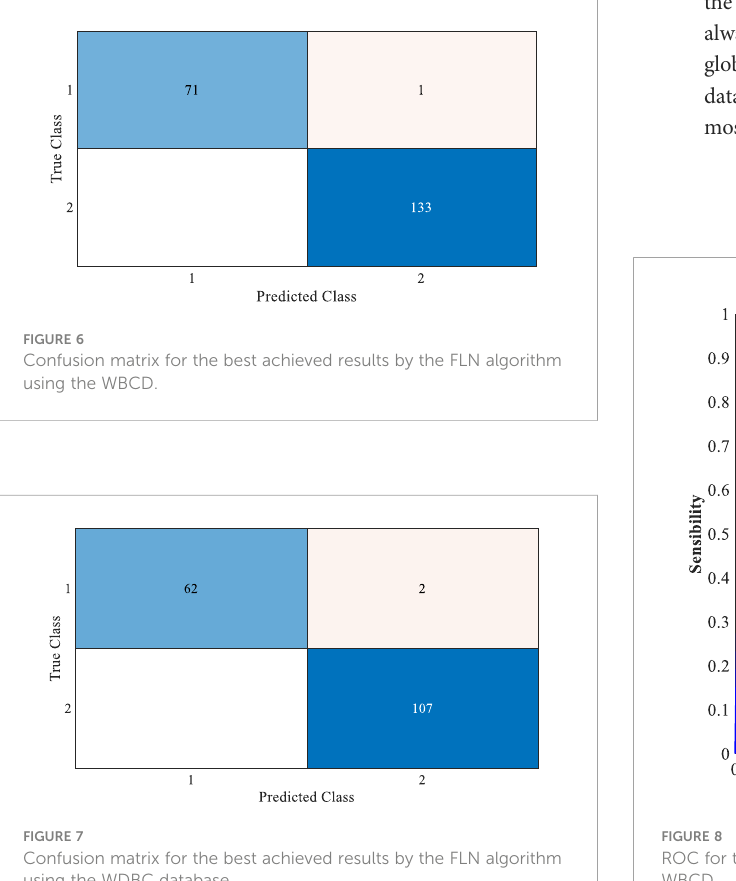
FIGURE 8 ROC for the best achieved results by the FLN algorithm using the